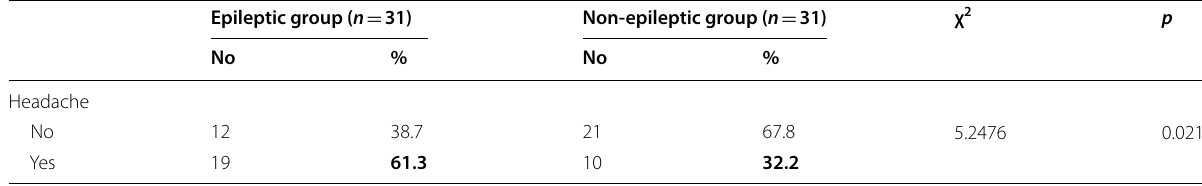
Table 3 Prevalence of headache in epileptic and non‑epileptic